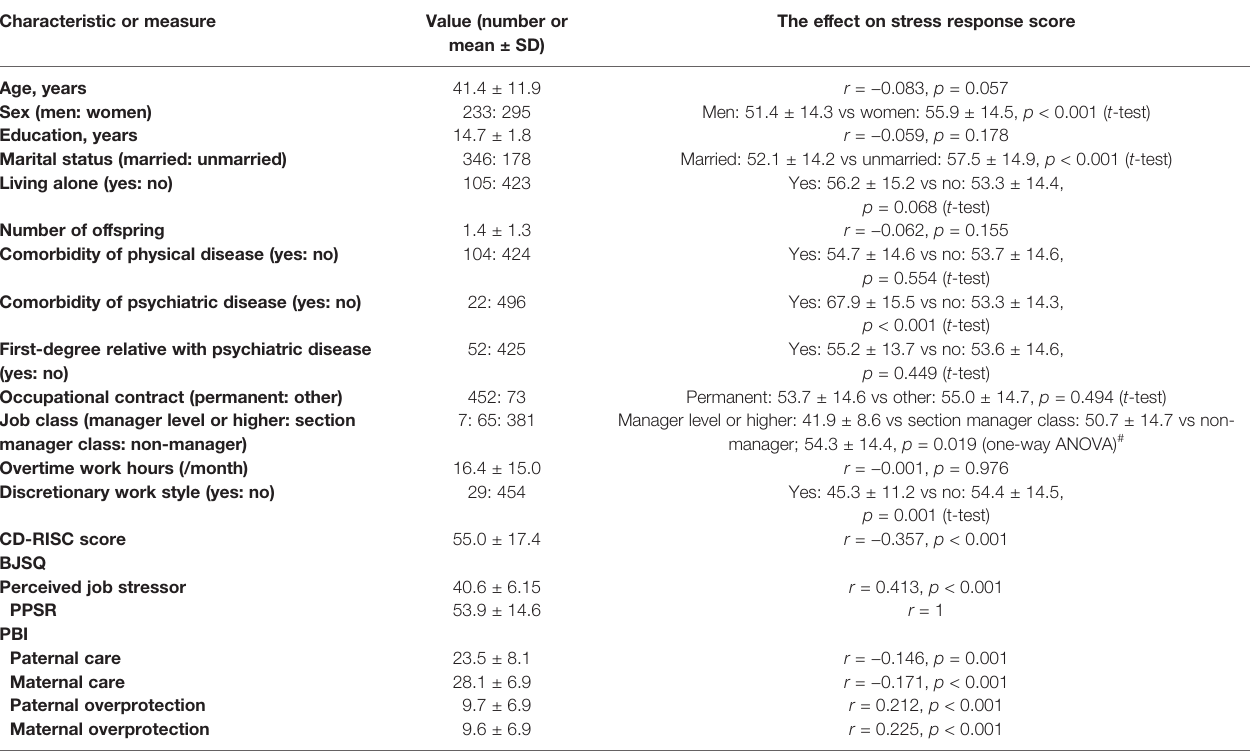
TABLE 1 | Characteristics, BJSQ, PBI, and CD-RISC of 528 adult workers and their correlation with PPSR score of BJSQ and effects on the stress response score. Characteristic or measure Value (number or The effect on stress response mean ± SD)